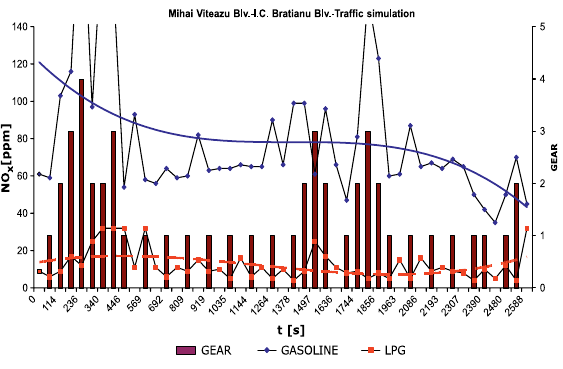
Fig. 15. Compared NO x emission versus time (air conditioning unit is turned off) for petrol/LPG fuel